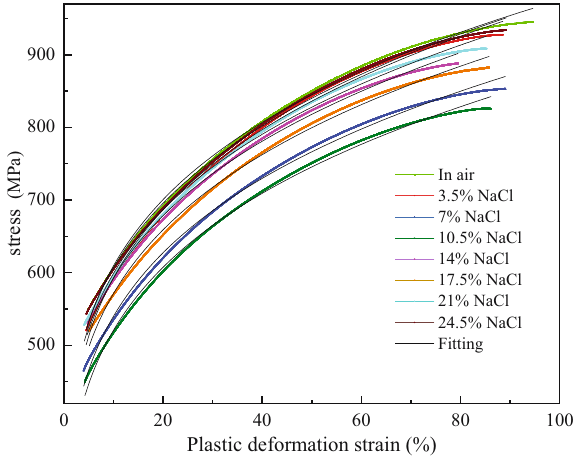
Figure 5: Fitting of plastic zone of specimen in air and NaCl solutions with di ff erent